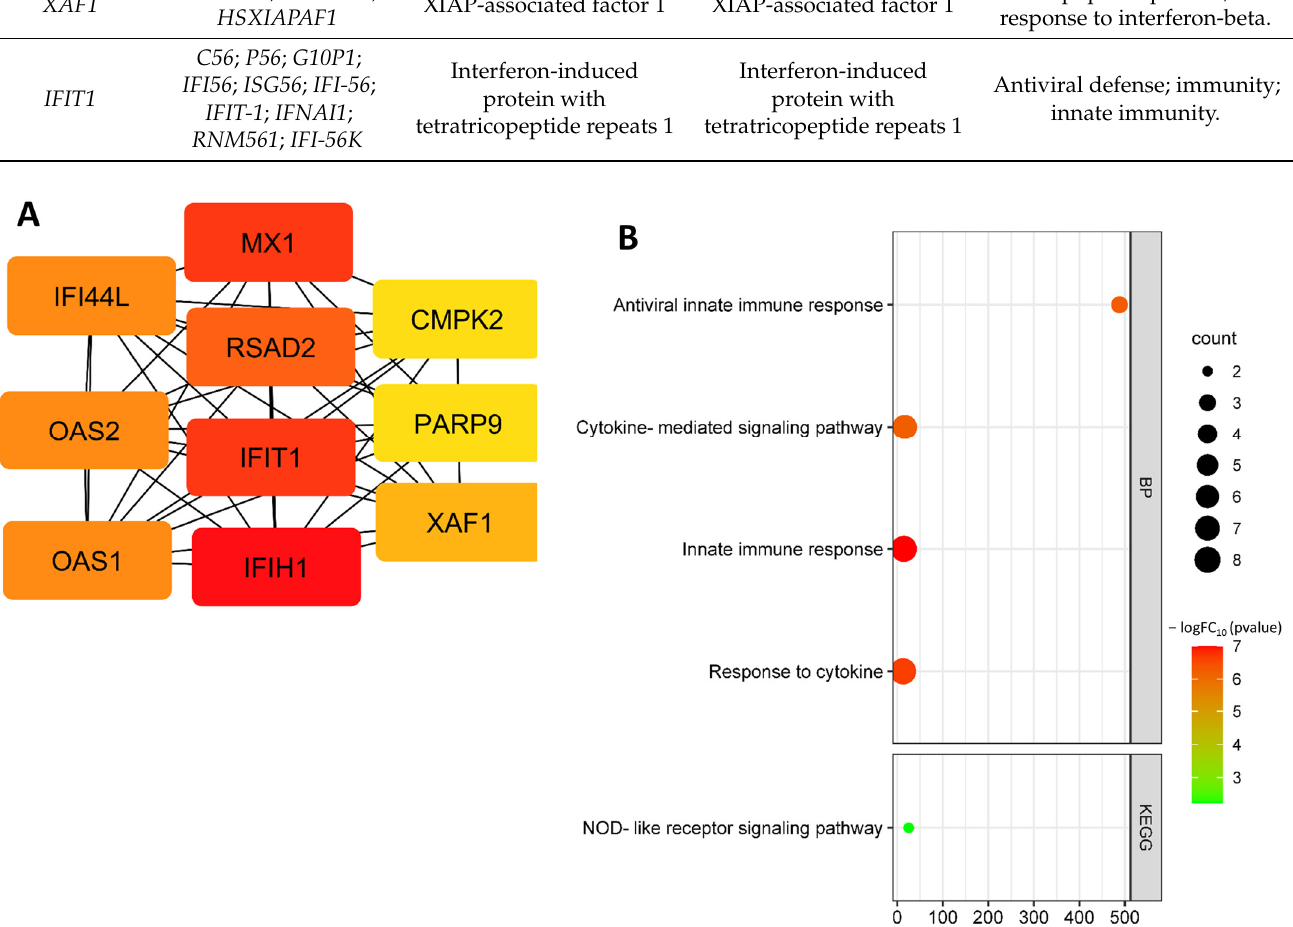
Figure 8. Down-regulated hub DEGs from dataset GSE141136 ( A ); functional enrichment of down- regulated hub DEGs from dataset GSE141136 ( B ). Note: the most important genes are ranked as follows: the most important genes are highlighted in red, less important genes in orange, even less important genes in yellow. Table 4. Functional roles and general information of the down-regulated hub genes.